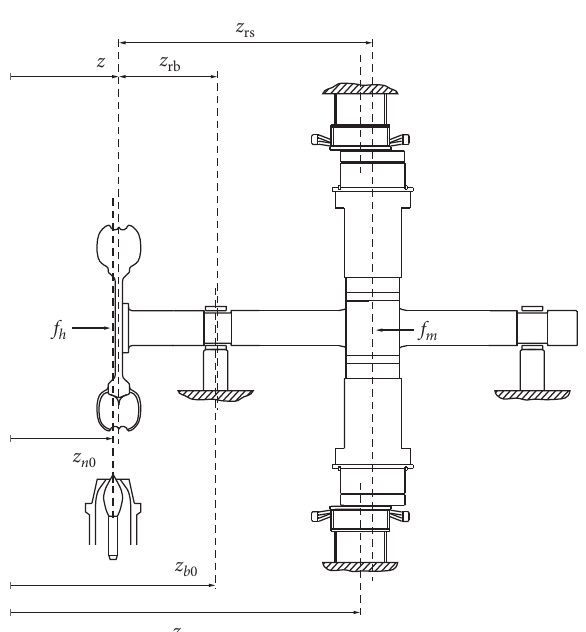
Figure 16: Model of Pelton turbine axial motion.